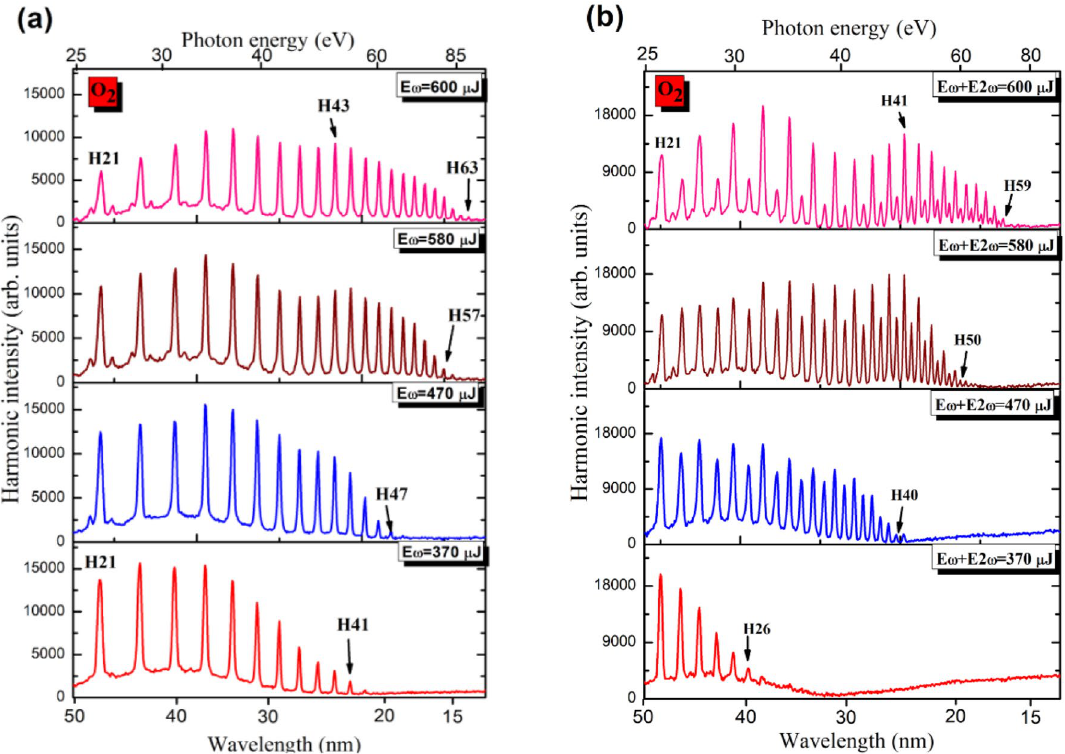
Figure 3. Spectra of harmonics generated in O 2 gas using ( a ) single-color field and ( b ) two-color field. In the cease of two-color field, the SH with CE = 2.8% was generated in 0.1-mm thick